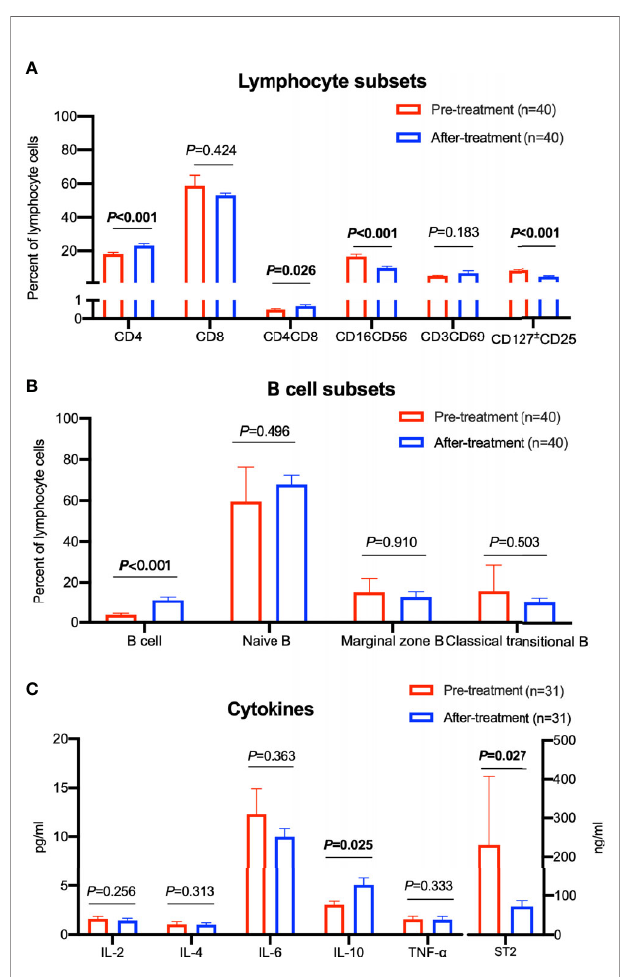
FIGURE 2 | Comparison of different lymphocyte subsets and cytokine levels before and after treatment with ruxolitinib. (A) Comparison of different lymphocyte cell subsets. (B) Comparison of different B cell subsets. (C) Comparison of different cytokine levels. Paired sample t test was used for the analysis. The numbers of patients are indicated in each